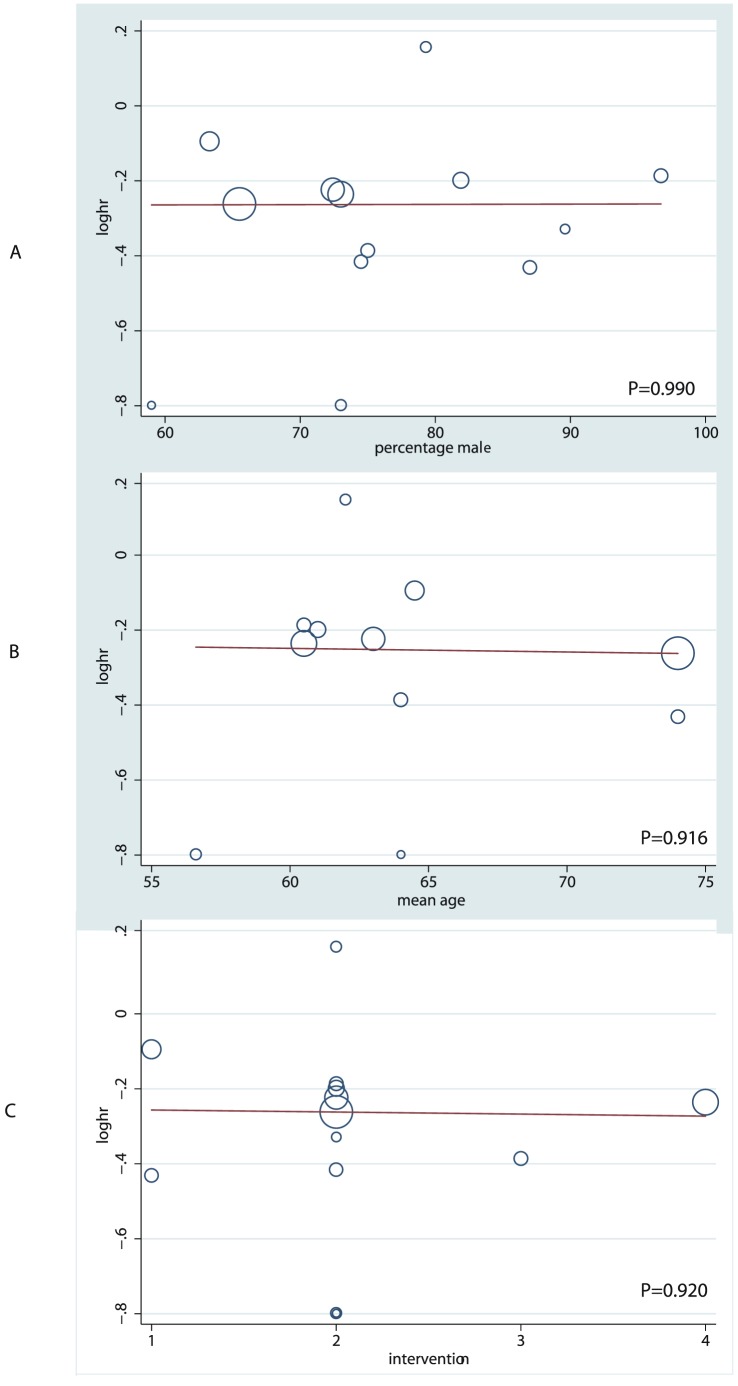
Meta-regression of (A) percentage male, (B) mean age, and (C) interventions for overall survival.